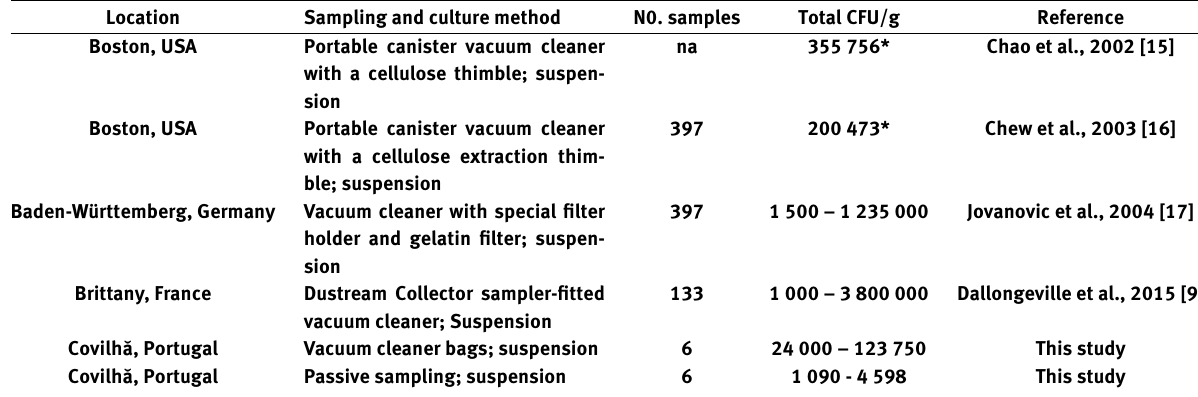
Table 2. Comparison of the total amount of fungi detected in different surveys worldwide. Total CFU/g: Total number of Colony Forming Units (CFU) per gram of dust. *average values. na: information not